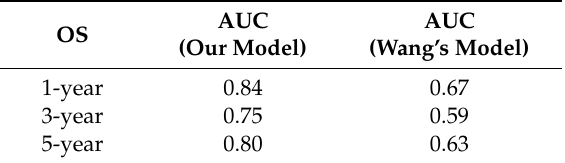
Figure 7. Comparison of our four-MDELs model and other literature model. The red and blue lines represent the ROC curve of the four-MDEL mode and Wang’s four-MDEG model respectively for Table 2. Comparison of our model and other literature models.